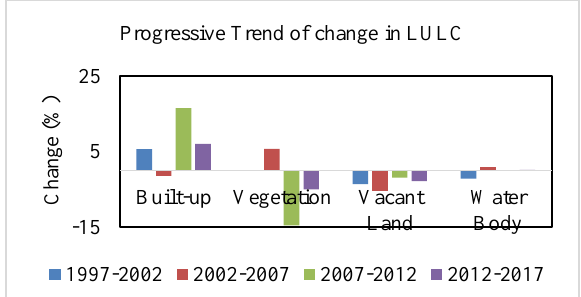
Figure 3. Trend of Change (%) in LULC 2017; and decreased by 137 ha (1.12%) of the study area from 1997 to 2017 (Figure 4). Table 3. Change matrix of LULC